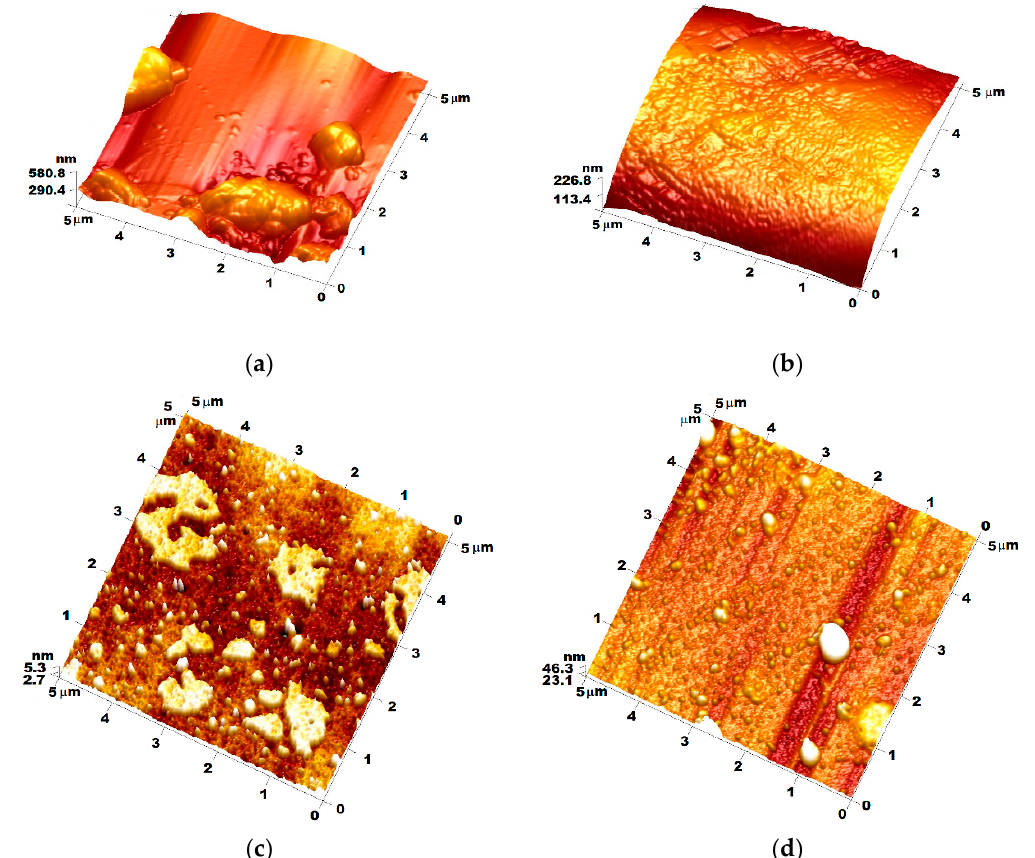
Figure 5. Topography AFM images of ( a ) M4, ( b ) M4-CC, ( c ) M2-CC, ( d )